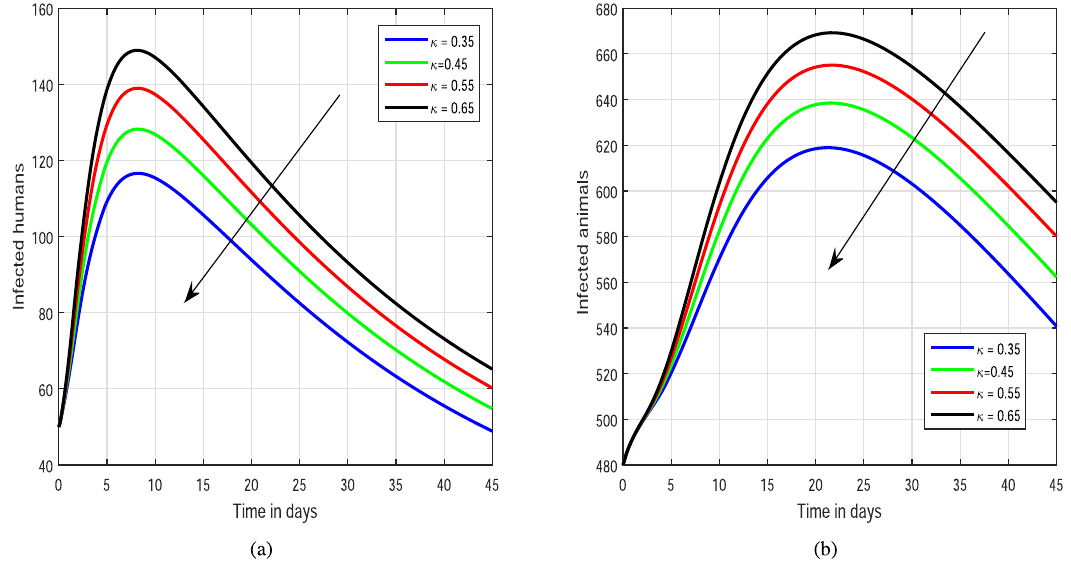
Figure 4: Representation of the time series of the infected individuals of the model ( 9 ) of zoonotic infection with variation of κ , i.e. = κ 0.35, 0.45, 0.55 , and 0.65.